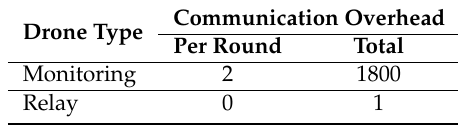
Table 3. Monitoring drones communication